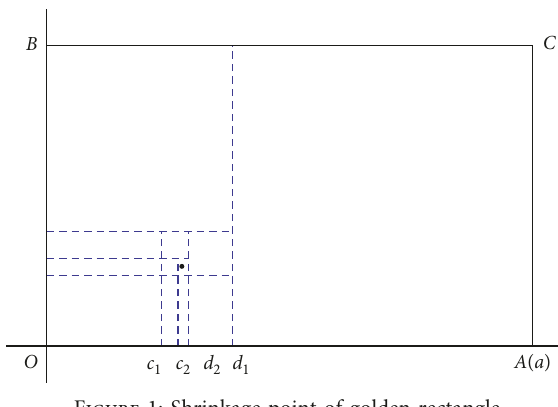
Figure 1: Shrinkage point of golden rectangle.